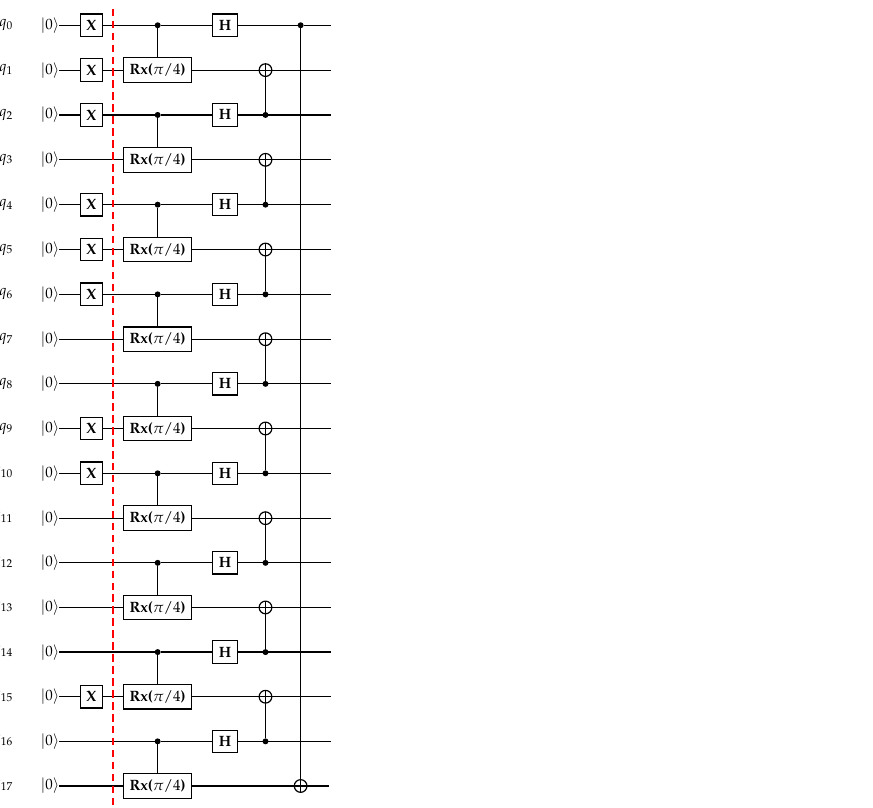
Figure 30. Global update circuit for the one-dimensional PQCA example. On the left side of the red dashed line are the gates to initialise the qubits.